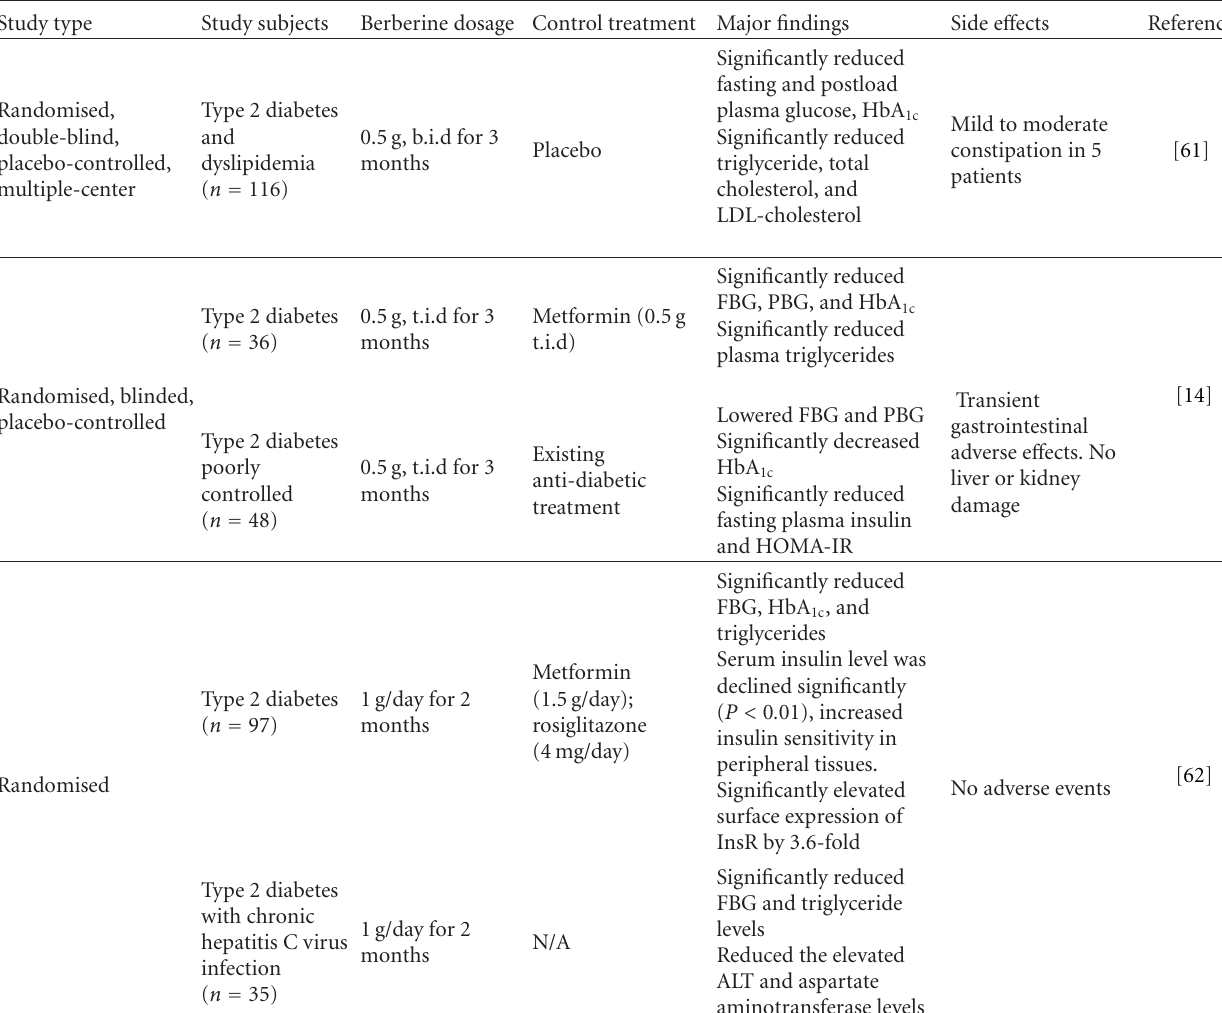
Table 6: Comparison of clinical studies of berberine in diabetes